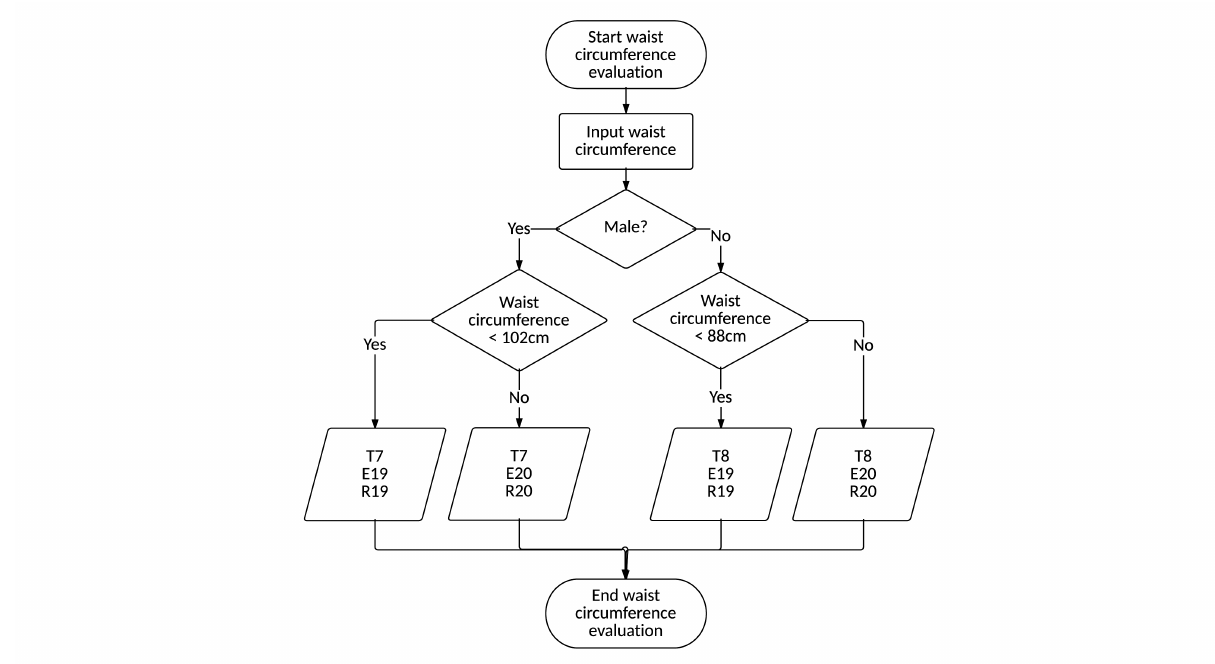
Figure 6. Algorithm for waist-circumference